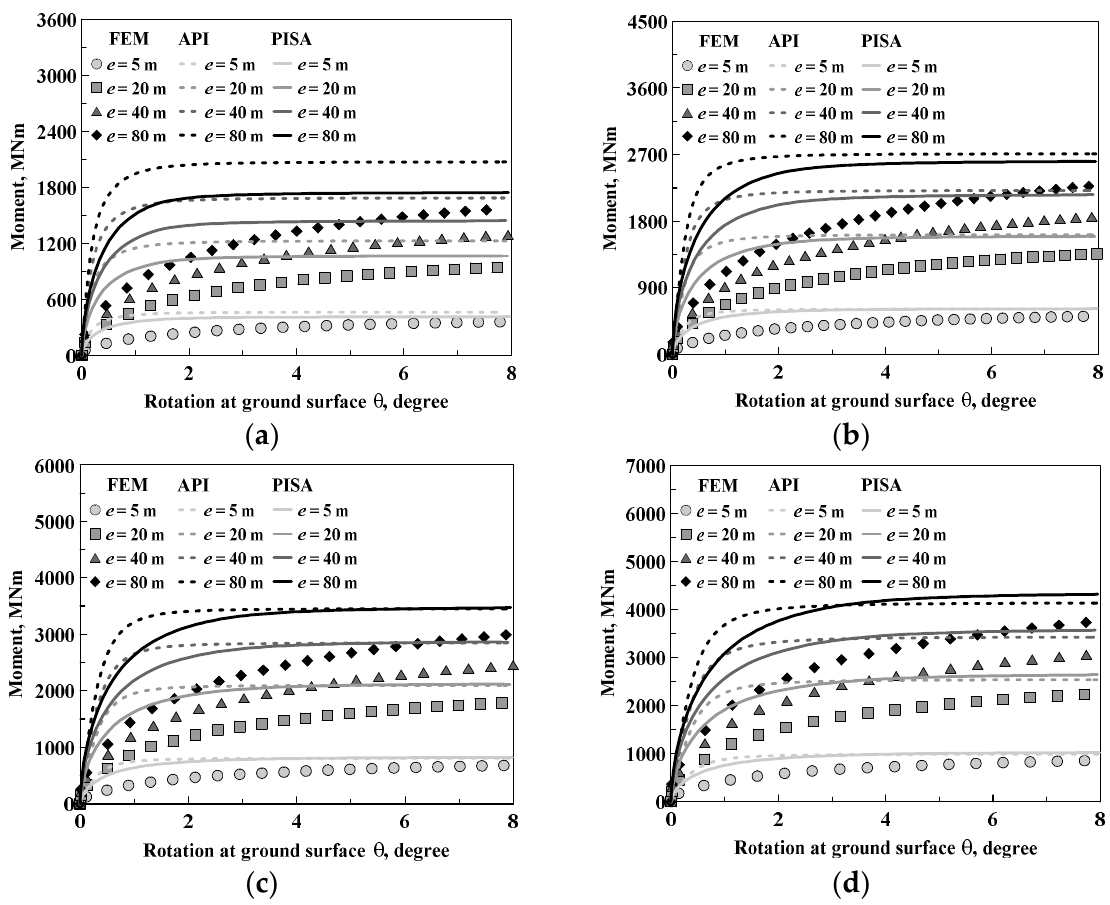
Figure 6. Moment–rotation curves at the ground surface in 65% relative density sand: ( a ) D = 4 m, ( b ) D = 6 m, ( c ) D = 8 m, ( d ) D = 10 m.